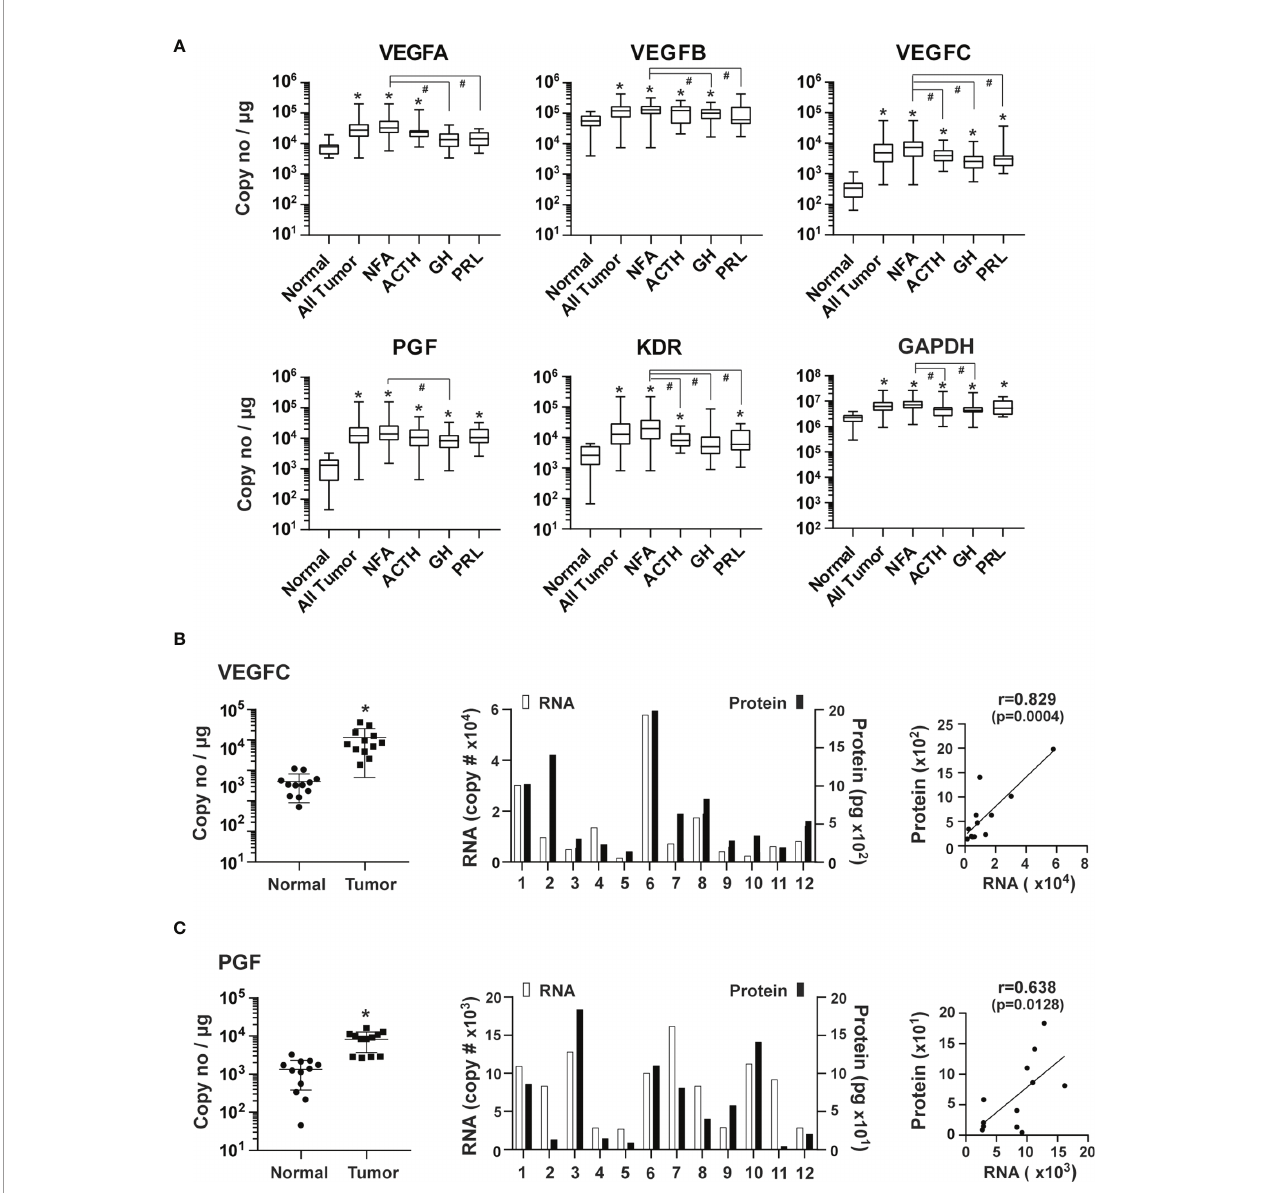
FIGURE 3 | Expression of VEGF family of growth factors in human pituitary tumors. (A) Expression of indicated genes was quanti fi ed by the TaqMan ® probe-based qPCR. Normal pituitary tissue, n = 12; NFA, n = 140; ACTH, n = 16; GH, n = 38; PRL, n = 13. *p < 0.05 vs normal pituitary tissue; #p < 0.05 vs NFA. (B) VEGFC and (C) PGF, Correlation of RNA and corresponding protein expression in an additional 12 pituitary tumors, including 11 NFA and 1 GH-secreting tumors. Left panel , RNA levels of endothelial markers in pituitary tumors and normal pituitary tissue. *p < 0.05 vs normal pituitary tissue. Middle panel , RNA and protein levels of individual pituitary tumors. RNA levels (open bars) were indicated on the left y-axis as copies of transcript/ m g total RNA. Protein levels (solid bars) were indicated on the right y-axis as pg/mg of tumor tissue. Right panel , correlation between RNA levels determined by qPCR and protein levels determined by